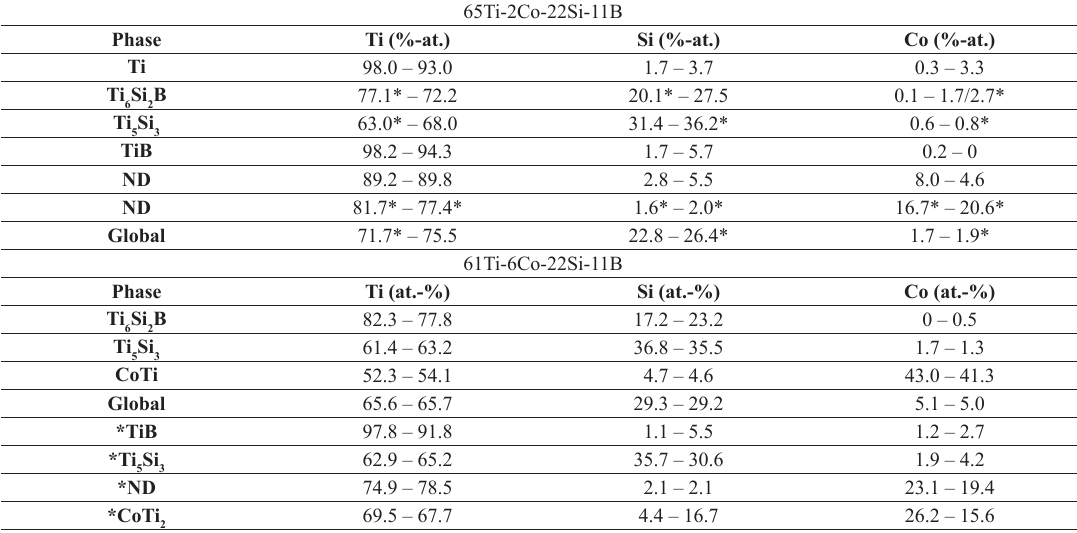
Table 5. Typical Ti, Si and Co (at.-%) contents measured by EDS analysis in phases formed of the SPSed 65Ti-2Co-22Si-11B and 61Ti- 6Co-22Si-11B alloys produced with powders milled for 20 and 300 min.